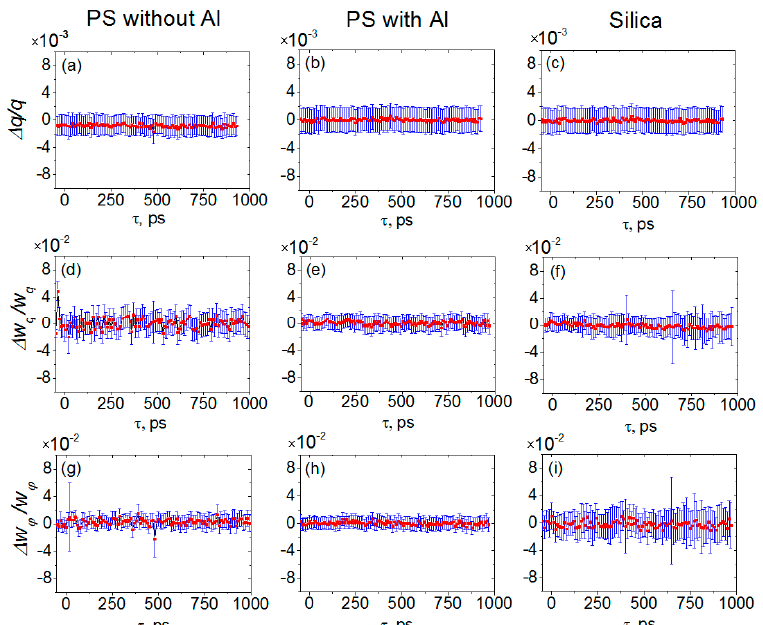
Figure 7. Time dependence of the relative change of the distance between the two opposite Bragg peaks Δ q ( τ )/ q ( a – c ) and Bragg peaks widths in radial Δ w q ( τ )/ w q ( d – f ) and azimuthal Δ w φ ( τ )/ w φ ( g – i ) directions for three selected samples. Analysis of the data was performed for the IR pump laser intensities shown in Figure 3 and 11.0 Bragg peaks indicated by a square in Figure 4.